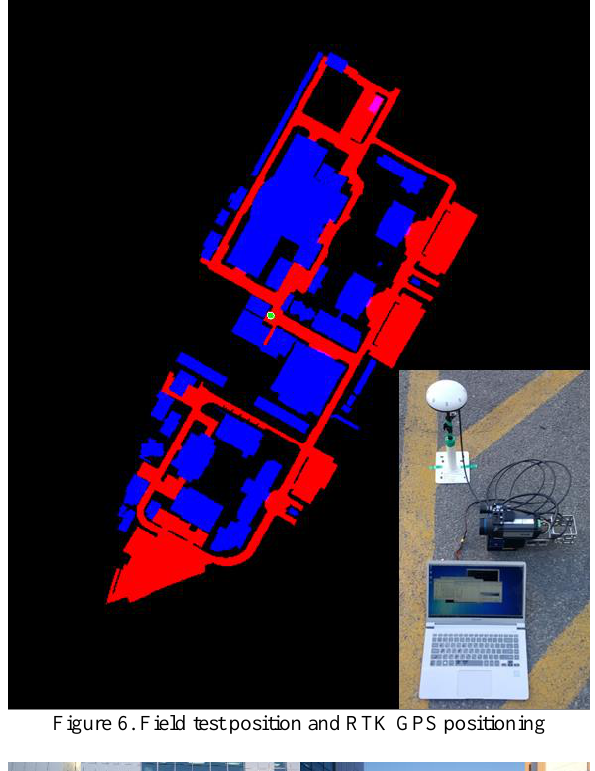
Figure 6. Field test position and RTK GPS positioning